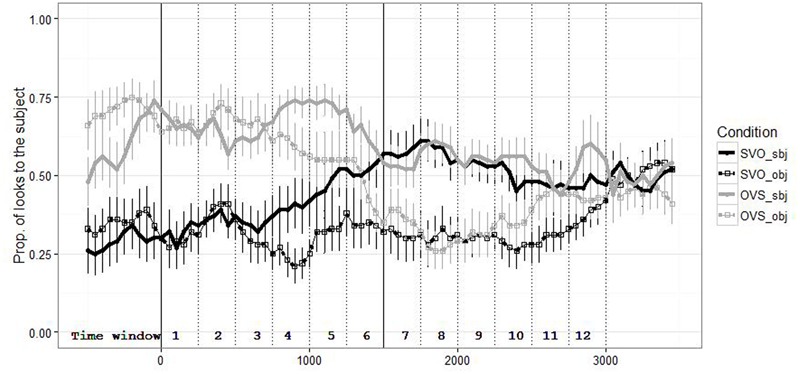
Mean proportion (with SE) of looks to the subject antecedent depending on Word Order and Pronoun. Standard errors (SE) exclude between-participant variance (Cousineau, 2005) and were normalized using Morey’s (2008) correction. Note that looks to the object antecedent were complementary to the looks to the subject.